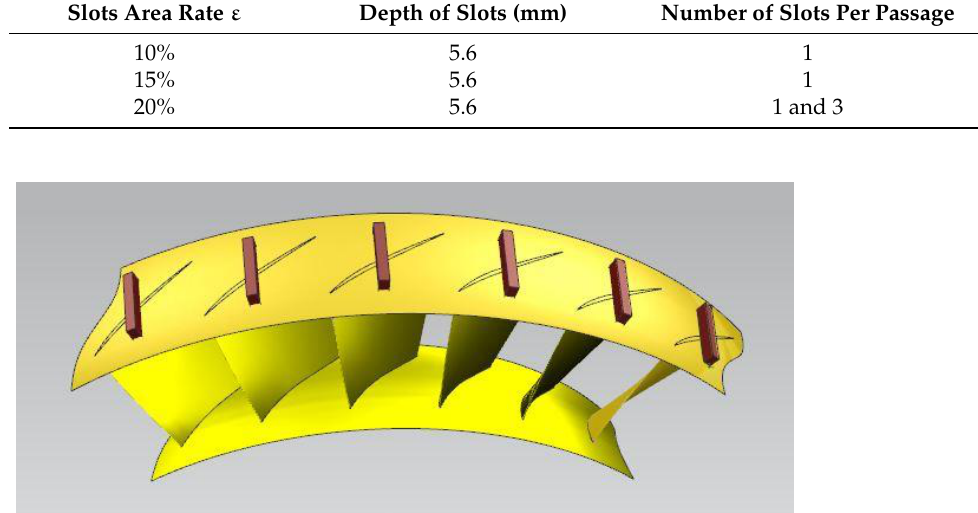
Table 2. The parameters of axial slots.